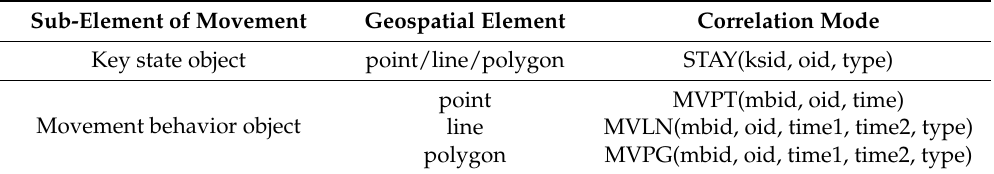
Table 1. The classified correlation